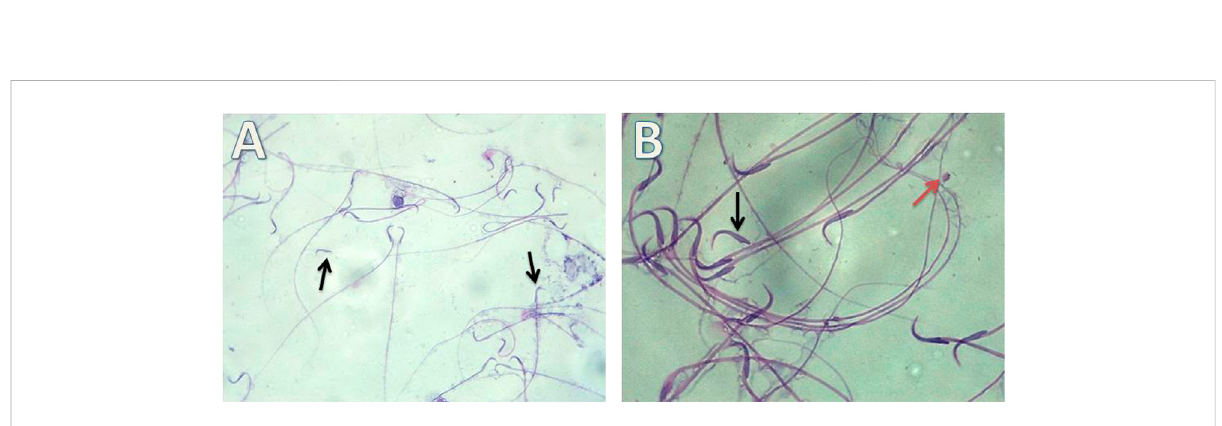
FIGURE 9 MicrographillustratingthemorphologyofspermsofGin-treatedalbinoratshowingsomespermsabnormalitiesasdetachedhead(blackarrow) and rounded head (red arrow) (H&E; (A) -X200, (B)